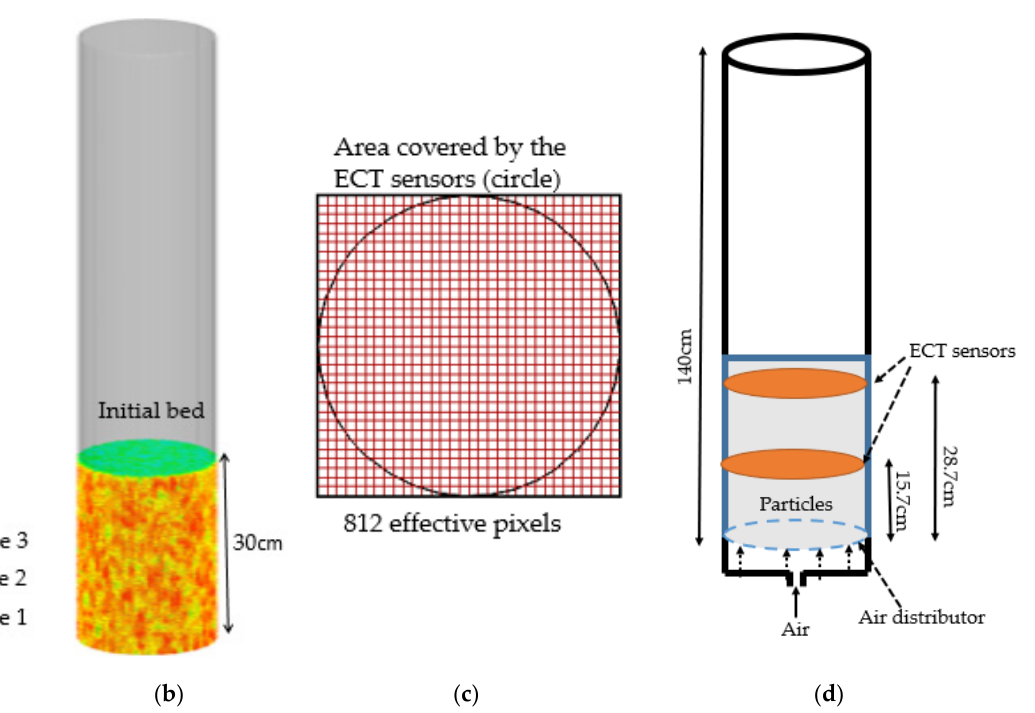
Figure 1. ( a ) Flux planes along the vertical height and boundary conditions; ( b ) initial bed height in CPFD model; ( c ) area covered by the ECT sensors; ( d ) schematic diagram of the experimental setup.